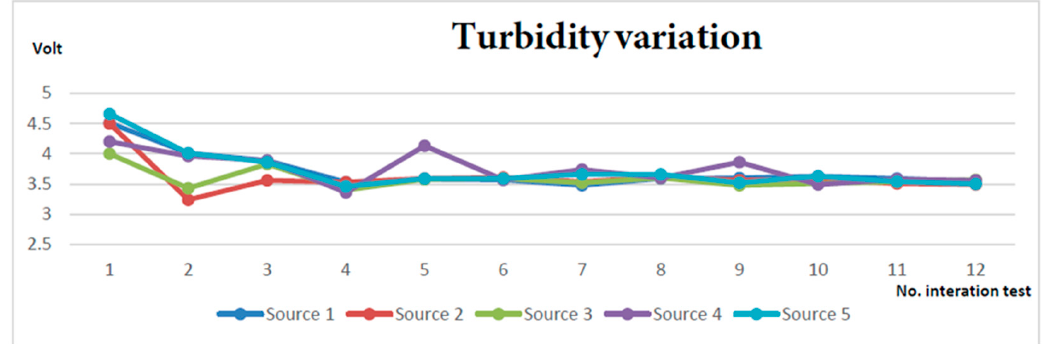
Figure 12. Turbidity variation for the tested water sources.